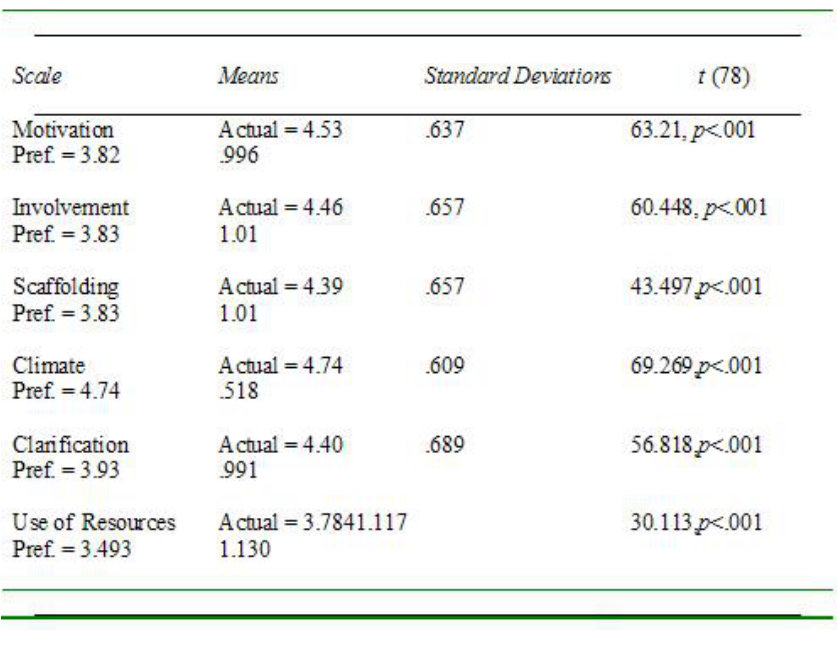
Table 5. Between Scale Correlations Calculated on Items Grouped into their Initial Tentative